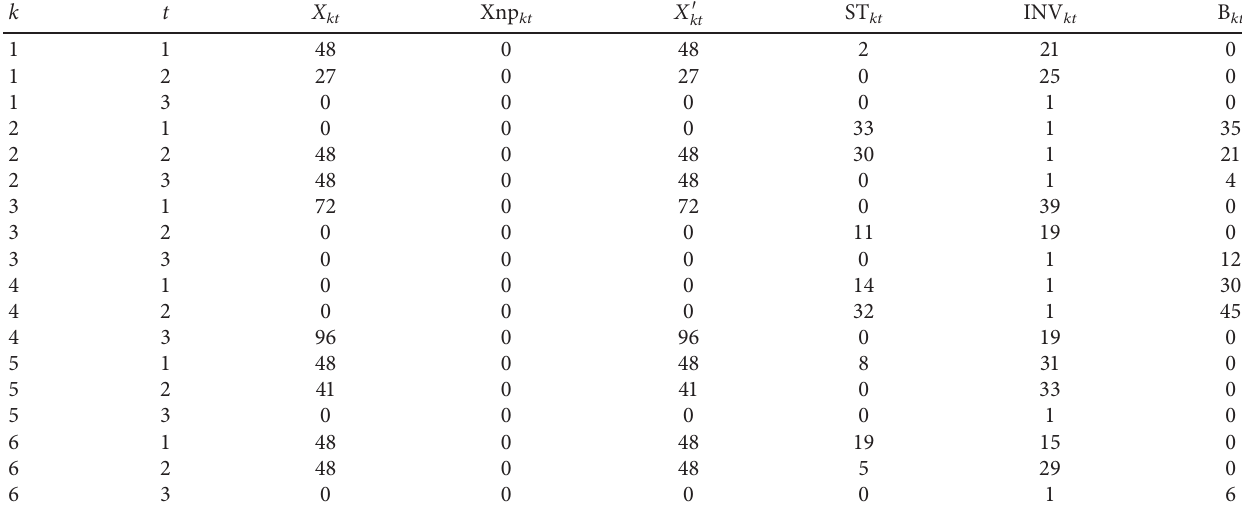
Table 6: Small dataset results of the base LSSP MILP: lot sizing, inventories, coverage, stockout, and backorders.